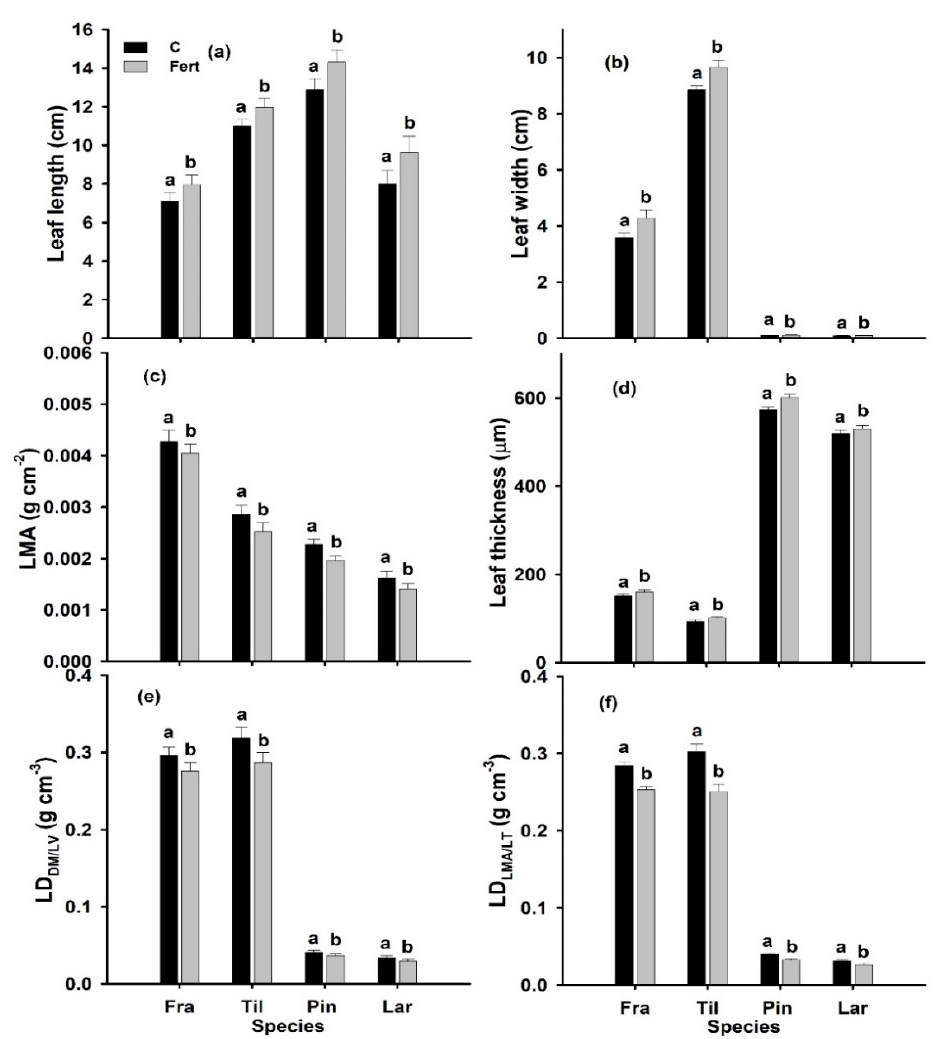
Figure 1. Leaf length (cm) ( a ), leaf width (cm) ( b ), leaf mass per area (LMA: g cm − 2 ) ( c ), leaf thickness ( µ m) ( d ), and leaf density (LD DM / LV , g cm − 3 ) ( e ), and LD LMA / LT (g cm − 3 ) ( f ) of mature sun-exposed leaves / needles of two-year-old seedlings of Fraxinus mandshurica (Fra), Tilia amurensis (Til), Pinus koraiensis (Pin) and Larix gmelinii (Lar) at control (C; no additional deposition; black bars) and after 10 g N m − 2 yr − 1 (Fert; grey bars) additional nitrogen deposition in NE China. Within species, significant di ff erences between treatments are indicated by di ff erent lower-case letters (Tukey’s HSD post hoc; p < 0.05; mean ± SE).